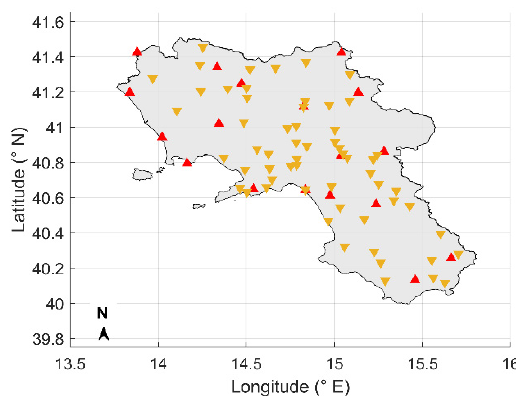
Figure A1. Eighteen ground weather station sites (red triangles) and 59 ground temperature station sites (orange triangles): 77 stations in total.